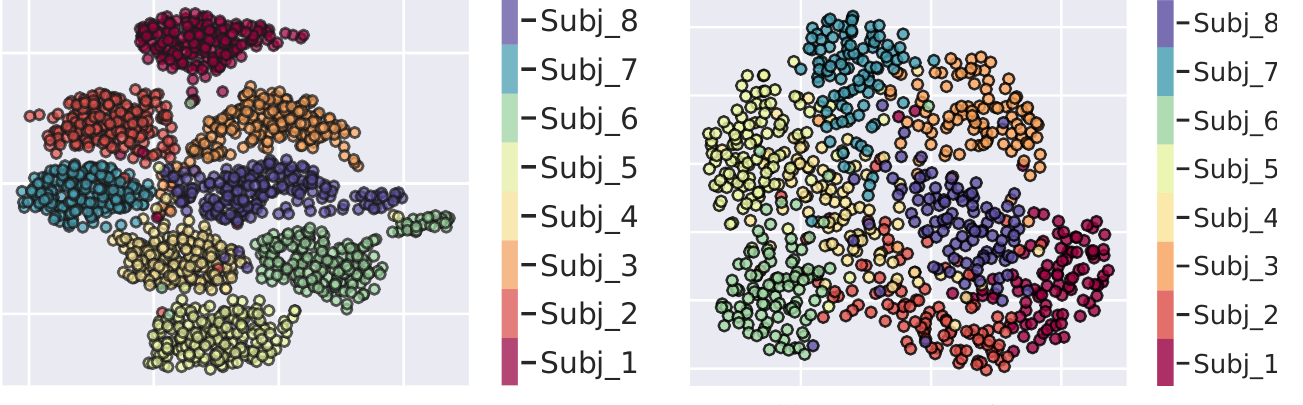
Figure 11. ( a ) Semi-supervised UMAP 2D projection of the concatenation of Fixations and Saccades O-U parameters. Each point represents the parameters extracted from one subject on an image of the FIFA dataset; the different point of the same color indicate the same subject observing different images. ( b ) UMAP 2D projection of vectors from the Score level fusion representation. Each point represents a subject (identified by colour in the side bar) observing a specific